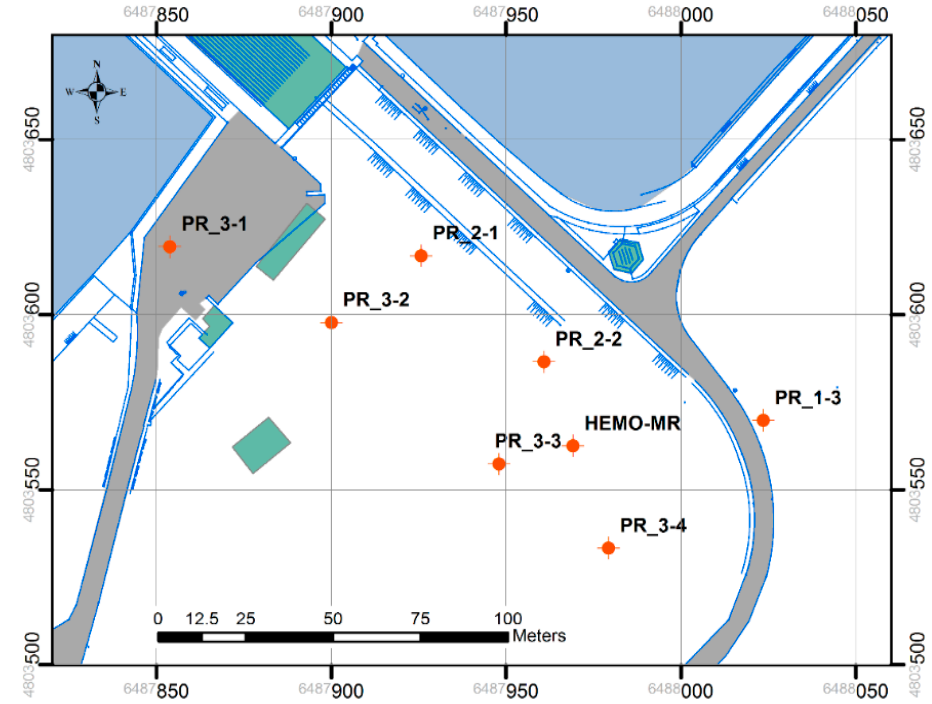
Figure 6. Disposition of piezometers around the diaphragm of HEPP Mostar [1].